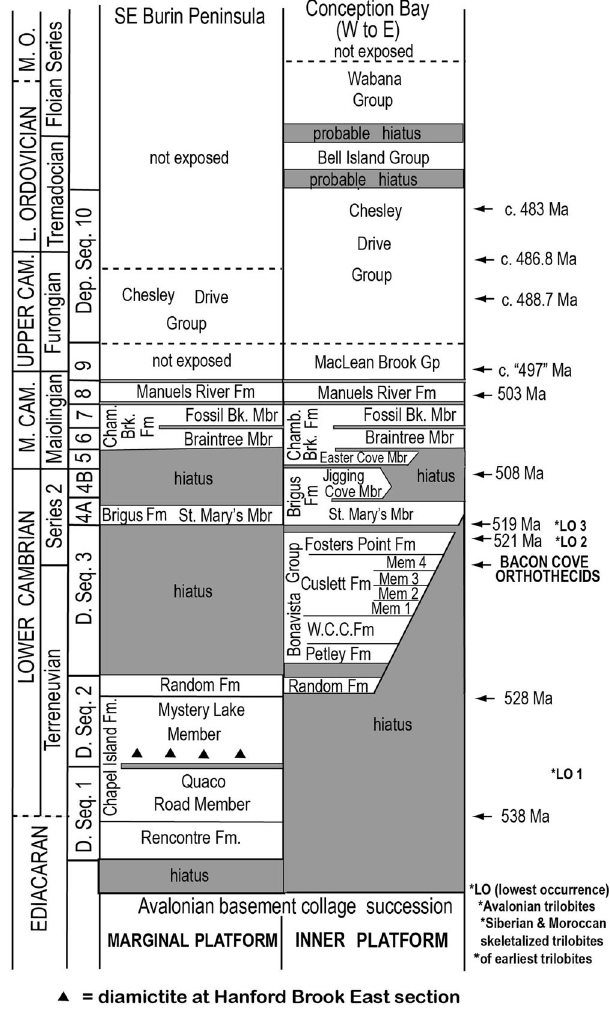
Fig. 1 Stratigraphy of Avalonian SE Newfoundland.